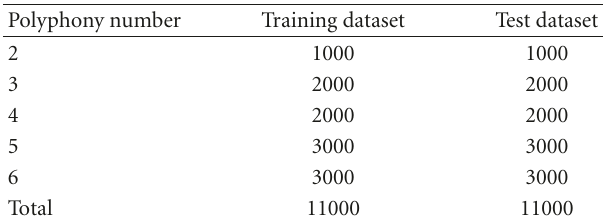
Table 2: Size of Training Set and Test Set.